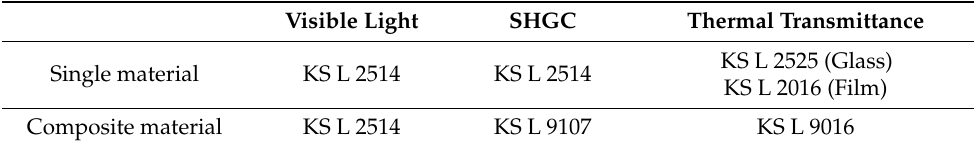
Table 2. Test standard according to cladding material and performance